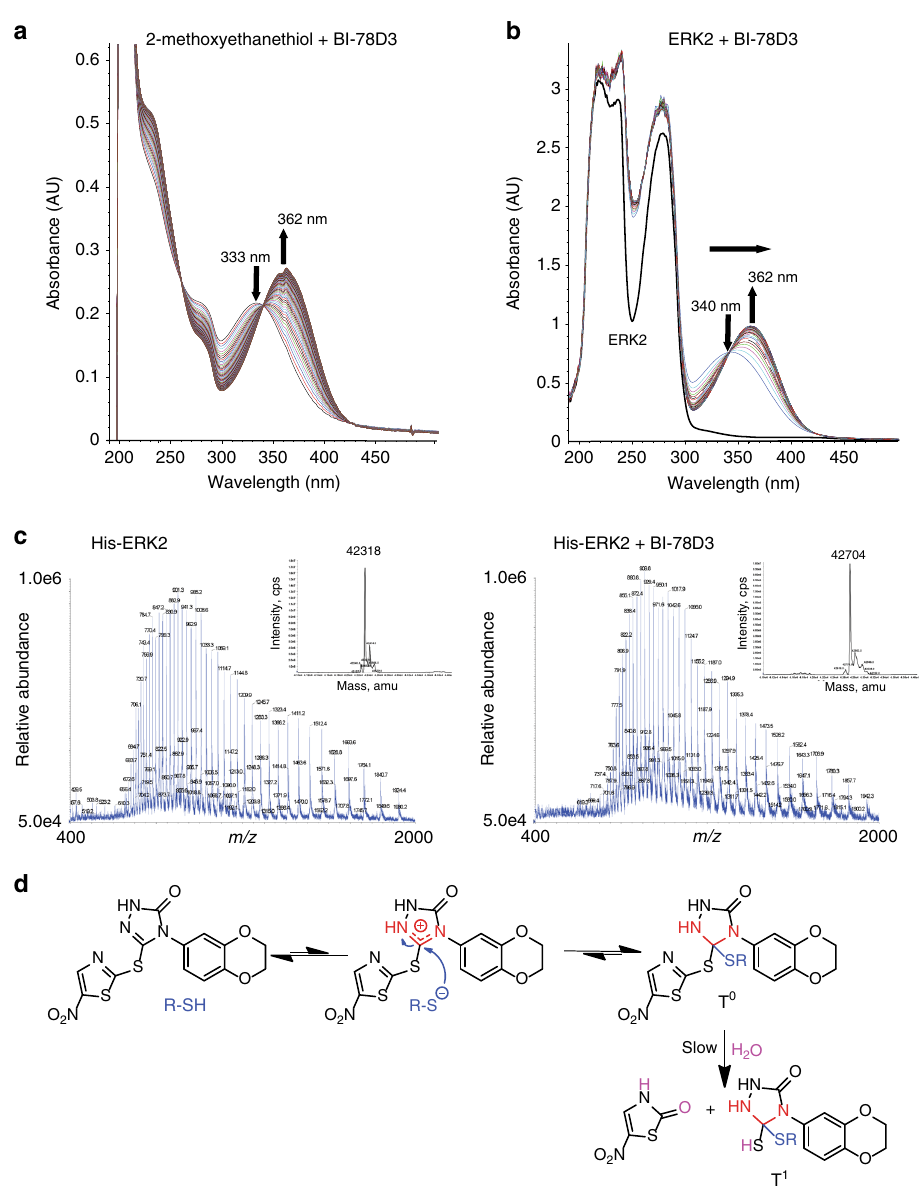
Fig. 2 BI-78D3 reaction with free thiols afford a stable tetrahedral intermediate. a , b Observed change in the UV-visible spectrum for the reaction of a 2- methoxyethanethiol (100 µ M) or b ERK2 (50 µ M) with BI-78D3 (10 µ M) in 50 mM phosphate buffer, pH 7.5 and 2% dioxane (spectra recorded every 10 s for 1000 s). c Deconvoluted mass spectra of ERK2 showing the addition of approximately 386 Da after incubation of ERK2 (5 µ M) with BI-78D3 (100 µ M) for 15 – 20 min, followed by buffer exchange using a PD-10 column (calculated molecular weights of BI-78D3 and ERK2 are 380 and 42,329 Da respectively). d Proposed mechanism of the reaction between BI-78D3 and